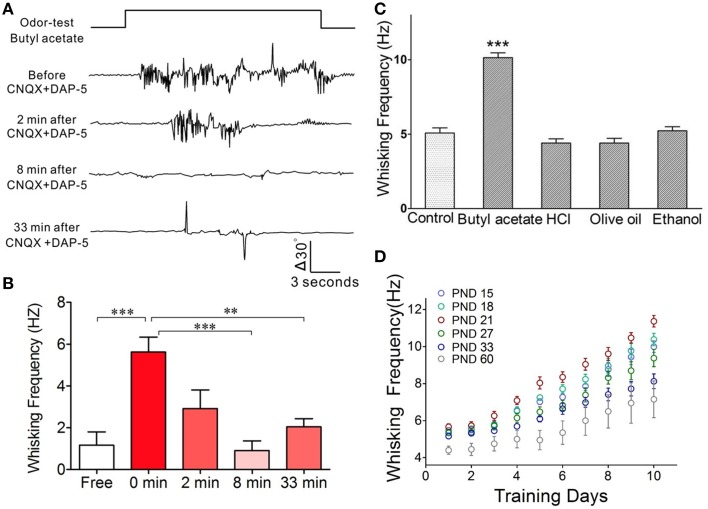
The barrel cortex is essential to odorant-induced whisker motion that is an odorant specific. (A) The blockade of neural activities in the barrel cortex removes odorant-induced whisker motion. In CR-formation mice, excitatory synaptic transmission in the barrel cortex was blocked by locally injecting CNQX/DAP-5 (400/500 μM), and neuronal spikes were blocked by locally injecting TTX (20 μM). The odor-test pulse was given toward the noses, and odorant-induced whisker motion was monitored by a digital video camera. Traces from the top to bottom show whisker motion tracks induced by the odor-test (top trace) toward the noses in a CR-formation mouse before and after injecting CNQX/DAP-5 for 2, 8, and 33 min. Calibration bars show whisker motion angle and time. (B) Shows whisking frequencies in CR-formation mice (n = 5) before and after injecting these reagents (p < 0.001) as well as for 0 vs. 8 and 33 min (p < 0.01; One-Way ANOVA). (C) In CR-formation mice trained by pairing WS and OS (butyl acetate), the whisker motions are examined by giving different odorants, such as butyl acetate (10%), hydrochloric acid (5%), olive oil (100%), and ethanol (75%). Odorant-induced whisker motion is seen by giving the test of butyl acetate only. Whisking frequency is increased by giving butyl acetate test (dark-gray bar), compared with that before WS/OS-pairing (light-gray; p < 0.05, n = 5; One-Way ANOVA), but not by the tests of hydrochloric acid, olive oil and ethanol (dark-gray). (D) Illustrates frequency in odorant-induced whisker motion vs. days in pairing OS and WS in different ages of the mice (postnatal days, PND 15, 18, 21, 27, 33, and 60; n = 12 for each of groups). The optimal age of the mice who are trained to express odorant-induced whisker motion is PND 21 when a maximal level of whisking frequency is seen. **p < 0.01; ***p < 0.001.